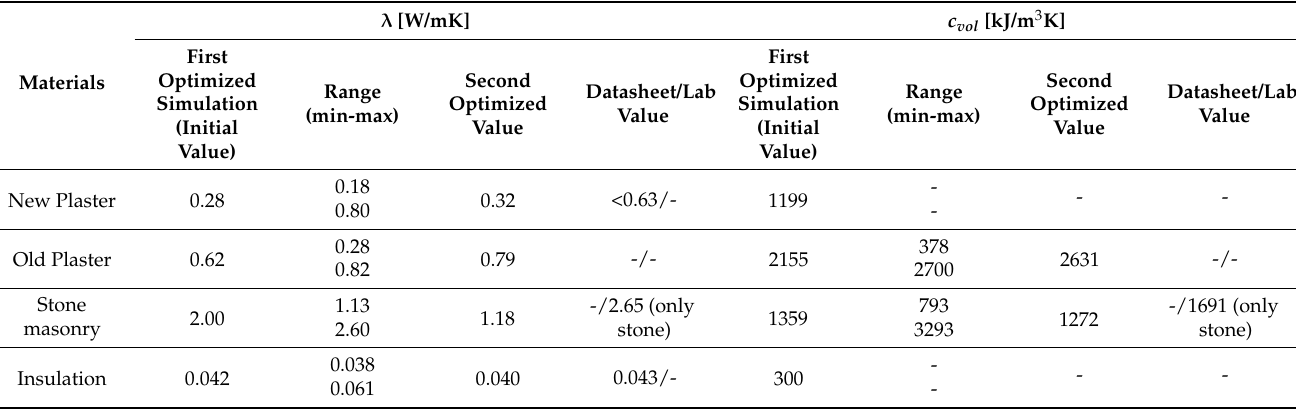
Table 4. Overview of the result of the second optimization step: range of variation, best solution, and datasheet or laboratory values, in terms of thermal conductivity ( λ ) and volumetric heat capacity c vol . The symbol “-” is used when no values are provided or no tests were carried